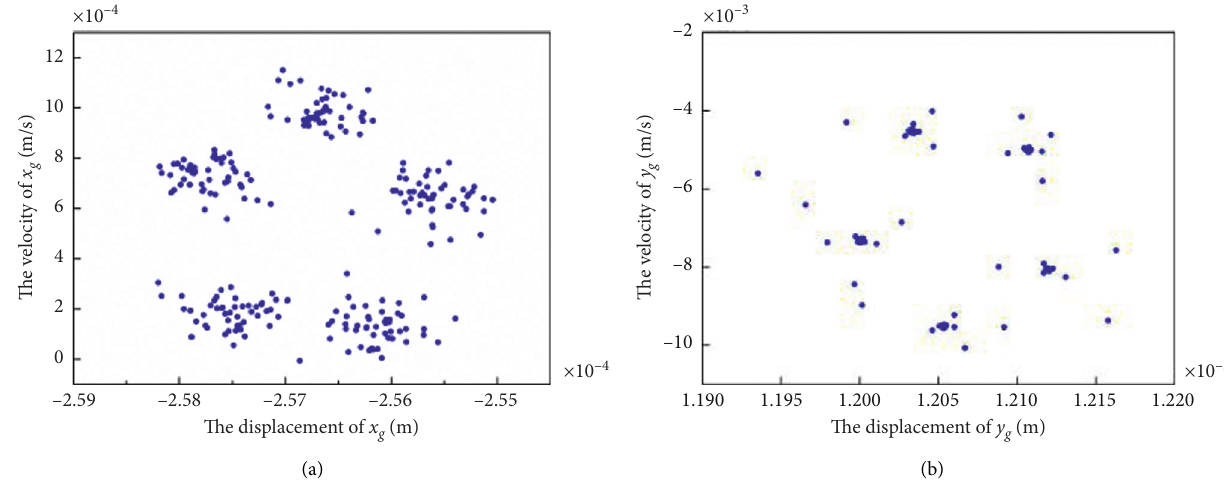
Figure 16: The Poincare mapping of driven gear at i � 1.25: (a) in x direction and (b) in y direction.